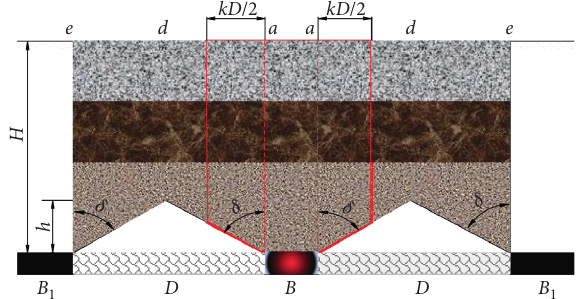
Figure 7: Diagram of the load on the coal pillar after optimization.